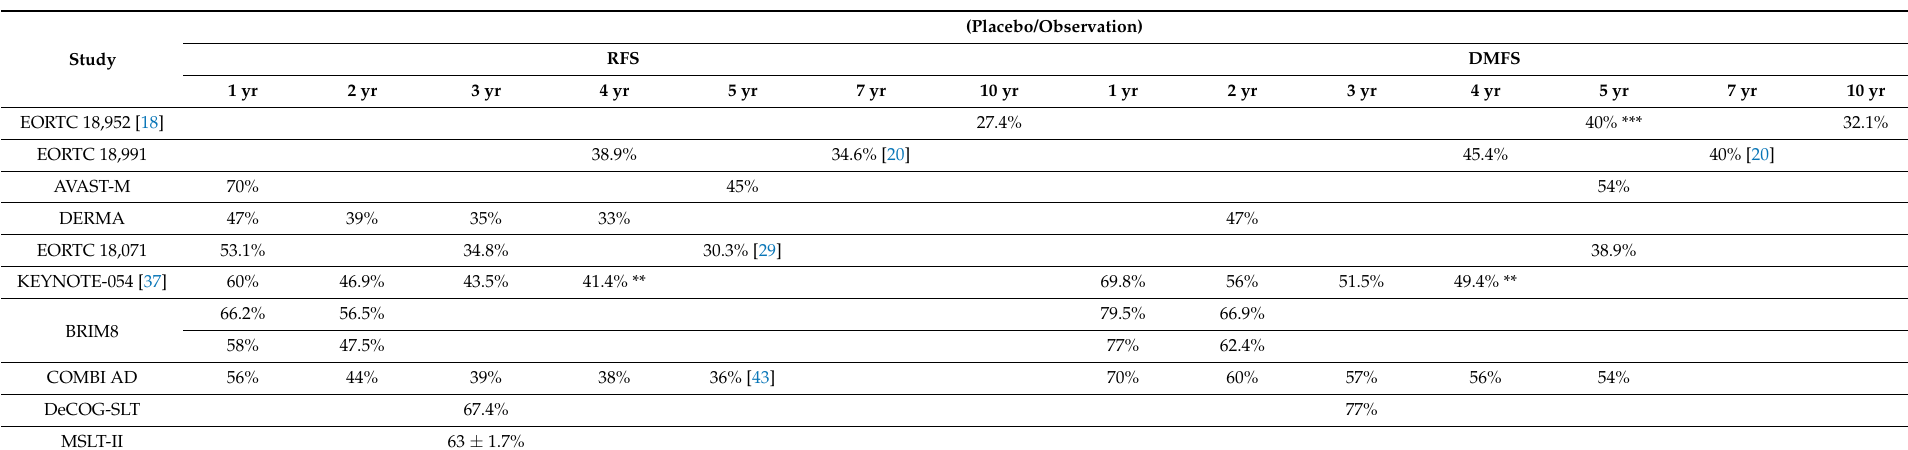
Table 3. RFS and DMFS of the observation/placebo arm(s) in the principal studies of adjuvant